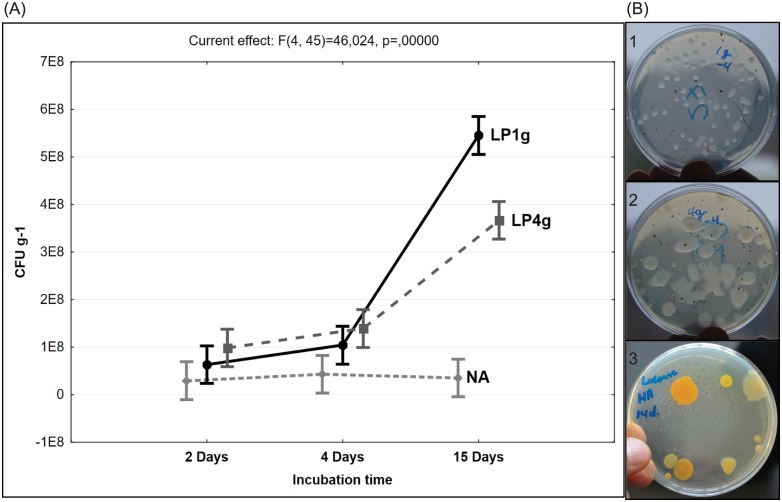
Cultivable rhizobacteria of Lucerne roots (CFUs g-1 root) developed on all tested culture media.A, ANOVA analysis (2-way interactions) of CFUs numbers of Lucerne rhizobacteria as affected by culture media and incubation period. NA, nutrient agar; LP1g, teabags of Lucerne powder 1.0 g l-1; LP4g, teabags of Lucerne powder 4.0 g l-1. B, Morphology of CFUs developed on agar plates of culture media prepared from teabags-only-containing Lucerne powder (4.0 g l-1 and 1.0 g l-1 culture media) as well as nutrient agar, inoculated with aliquots of 200 μl of the same root suspension (10−4): B1, confined/limited and transparent/translucent colonies on LP1.0 g l-1; B2, numerous slimy colonies on LP4.0 g l-1; B3, large tinted colonies on NA.